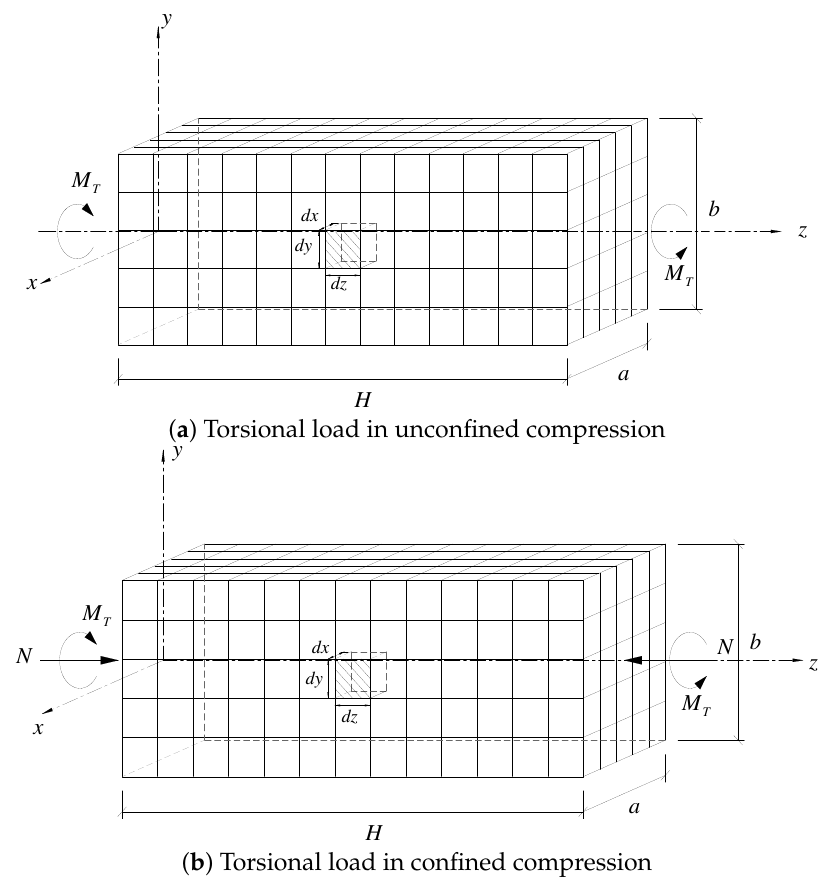
Figure 2. Application of the differential load on a prismatic